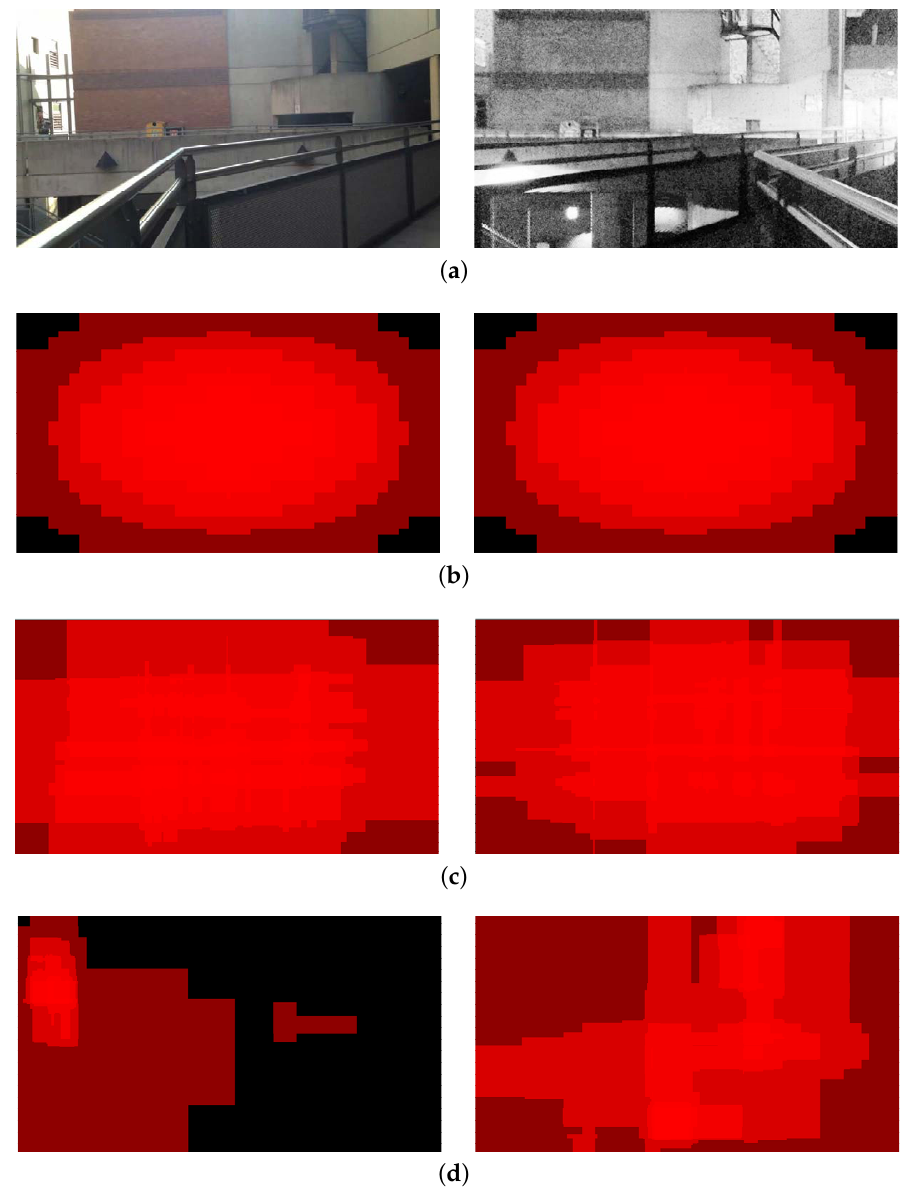
Figure 11. An example illustrating two images captured at the same place and the corresponding landmark distributions generated using different methods. ( a ) The query (left) and reference (right) images. The spatial distribution of landmarks extracted from the two images are obtained by: ( b ) our MSW method; ( c ) SP-Grid; and ( d ) Edge Boxes. Deeper color area indicates more coverage by